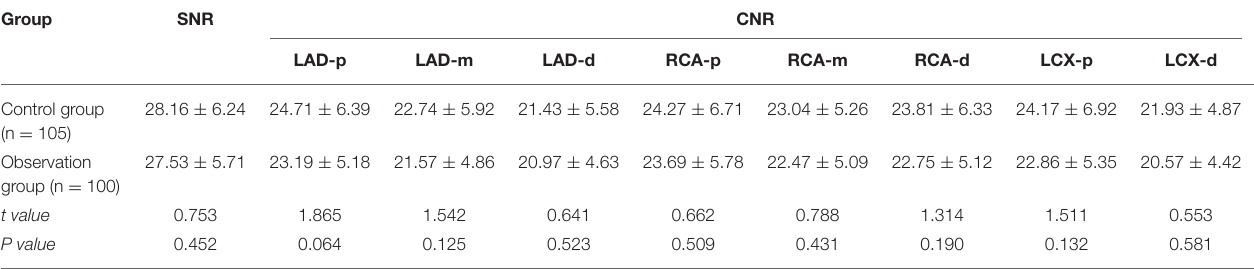
TABLE 3 | Comparison of signal-to-noise ratio (SNR) and contrast-to-noise ratio (CNR) between the two groups of patients ( n , x ± s, HU). Group SNR